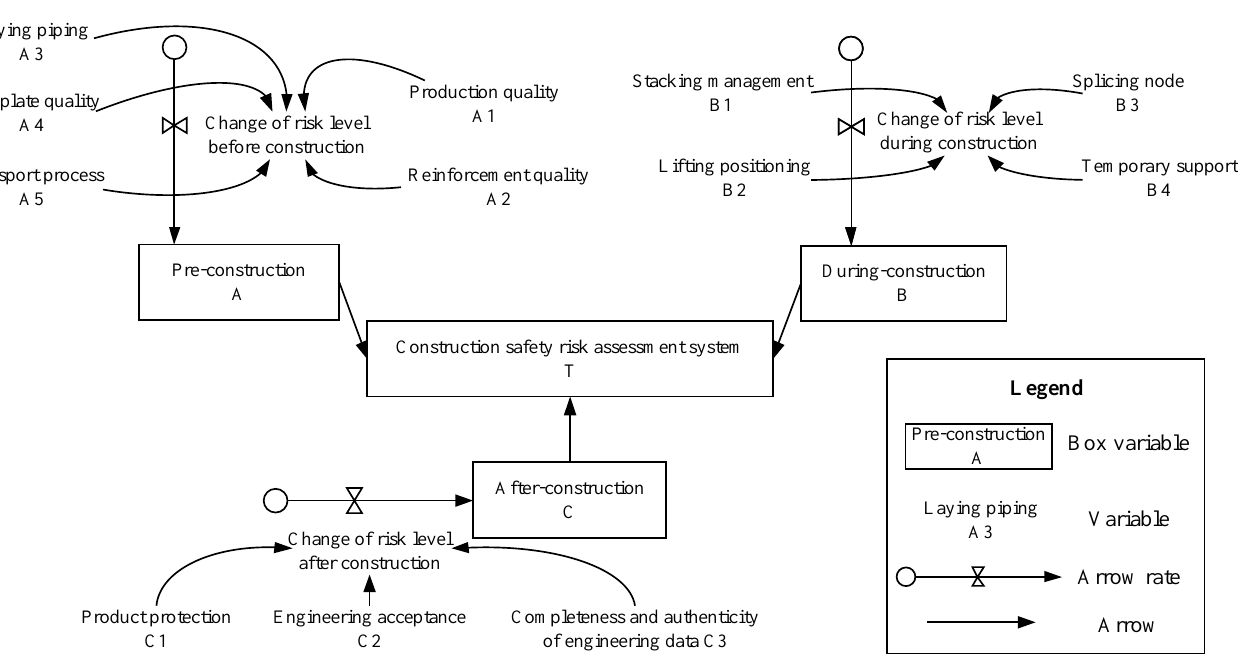
Table 3. Variable value and expression.